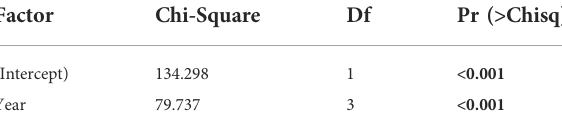
TABLE 3 Effect of “ Year ” on the number of detected residues.